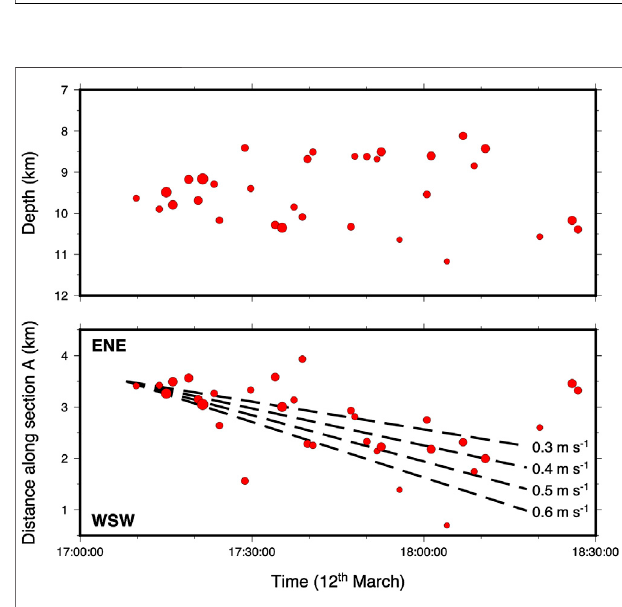
FIGURE 4 | Top: The variations of earthquake depth vs time (UTC) for the 12th March cluster in Figure 3 . This shows that the earthquakes increase in their depth extent through time. Bottom: Earthquake distance along section A ( Figure 3 ) vs. time. This shows a clear propagation of the seismicity WSW along-strike at a rate of 0.3 – 0.6 m s − 1 .